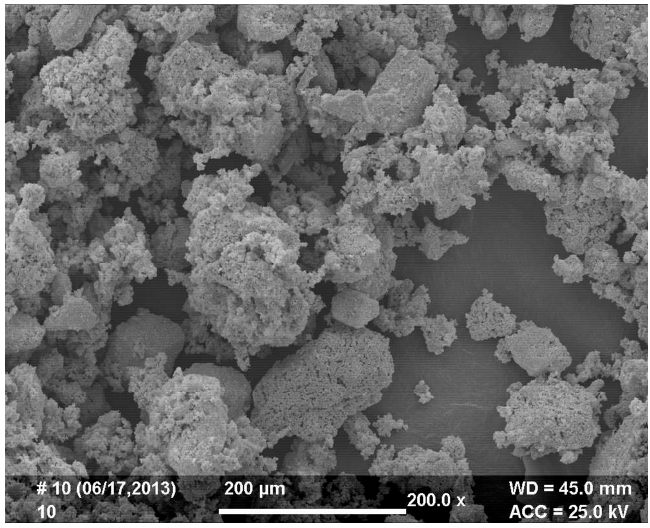
Figure 2. Microstructure of the Re-Ni powder, obtained after 1 h reduction at 800 ◦ C (200 × magnification).